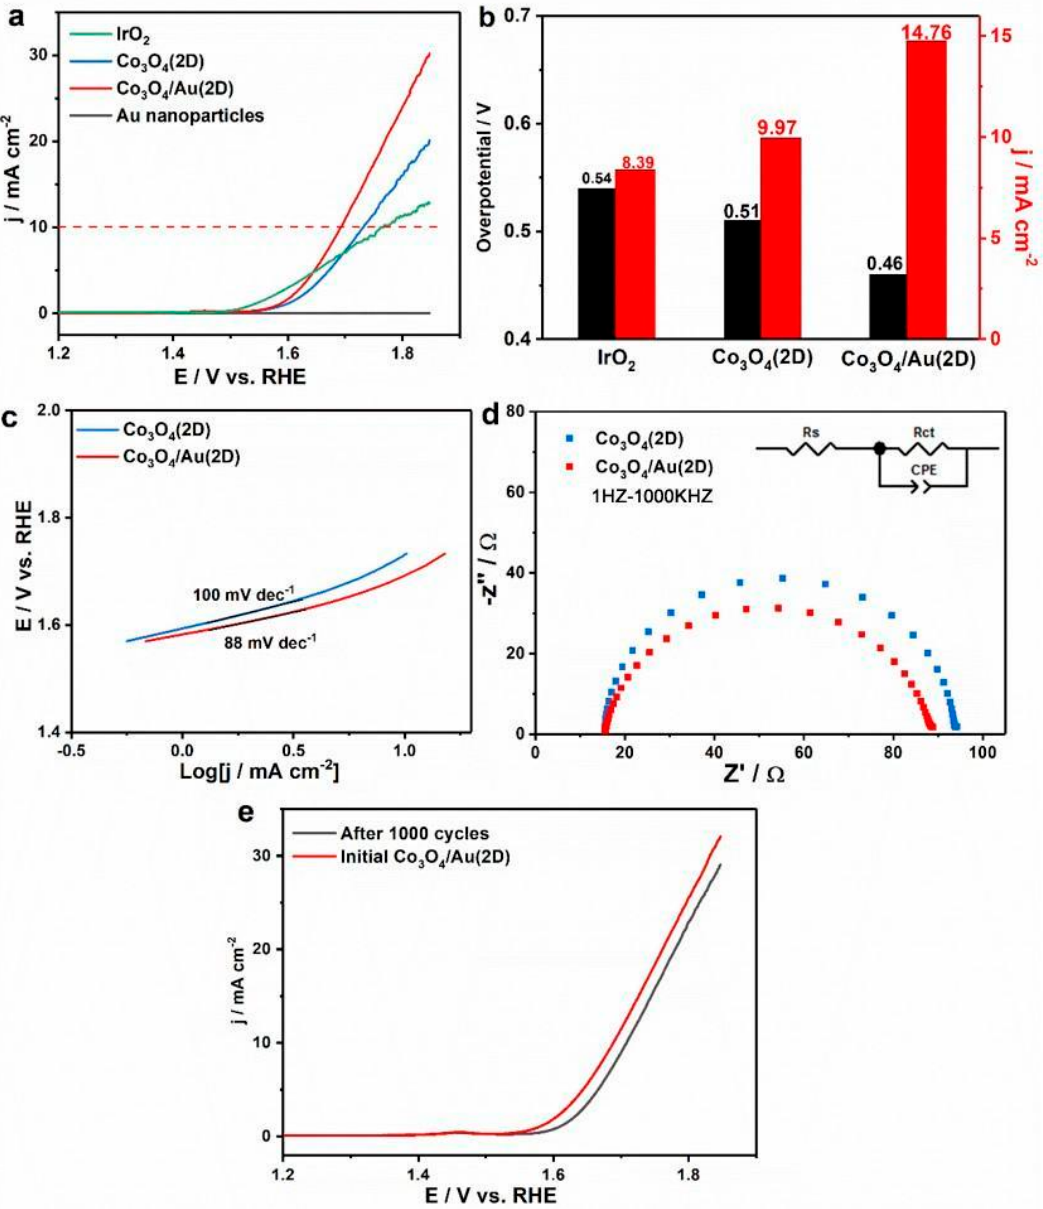
Figure 4. OER activities of the nanocatalysts: ( a ) LSV curves of Au nanoparticles, IrO 2 , Co 3 O 4 ultrathin nanosheets, and Co 3 O 4 /Au nanocomposites; ( b ) comparison of the current density at an overpotential of 0.5 V and the overpotential required for achieving a current density of 10 mA cm − 2 , for IrO 2 , Co 3 O 4 ultrathin porous nanosheets, and Co 3 O 4 /Au nanocomposites; ( c ) Tafel plots for Co 3 O 4 nanosheets and Co 3 O 4 /Au nanocomposites; ( d ) EIS of Co 3 O 4 nanosheets and Co 3 O 4 /Au nanocomposites; and ( e ) LSV curves of the Co 3 O 4 /Au nanocomposites before and after 1000 cycles.